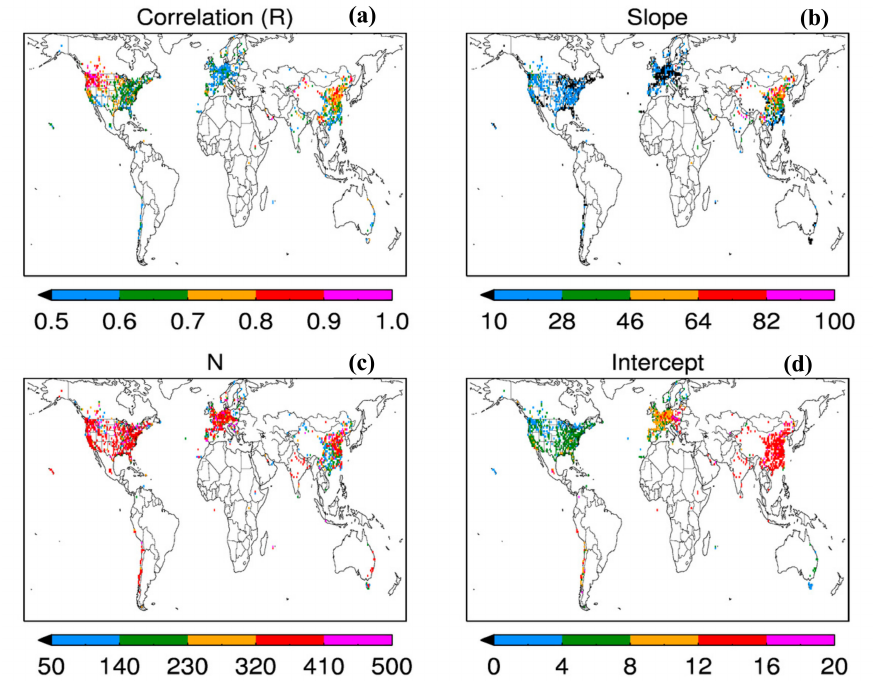
Figure 3. Global distribution of AOD–PM 2.5 relationship statistics in 1 × 1 degree grids, ( a ) Linear Correlation Coe ffi cient, ( b ) Slope, ( c ) Number of surface Monitors, and ( d ) Intercept.